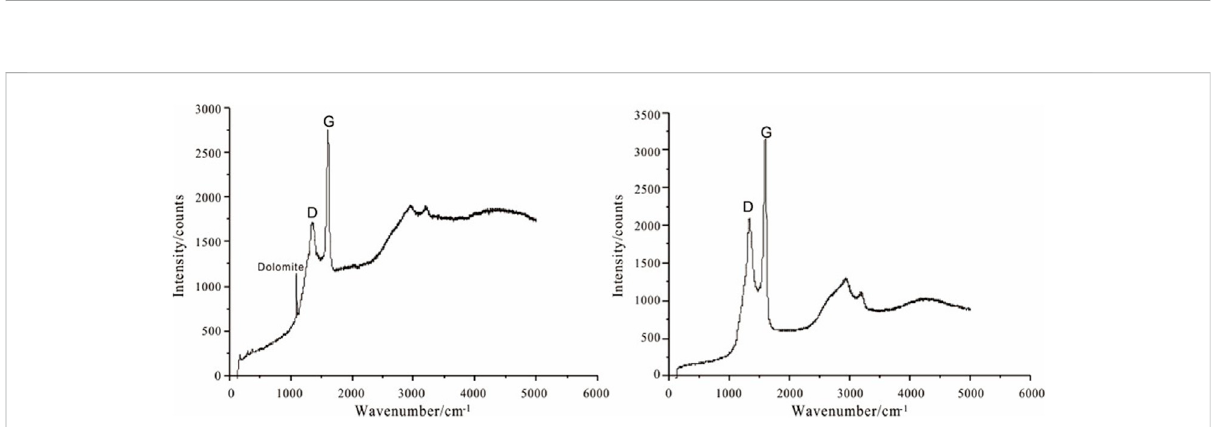
FIGURE 4 Laser Raman spectrogram of solid bitumen in the Cambrian reservoirs. Left – bitumen in dolomite, ∈ 2 z, 4190.3 m, well L17; Right – bitumen in dolomite with intercrystalline pores, ∈ 2 z, 3920.2 m, well